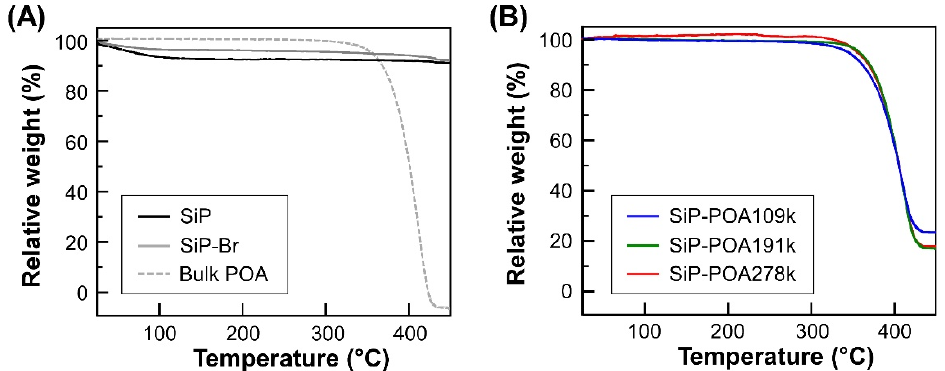
Figure 2. TGA curves for SiP, SiP-Br, bulk POA ( A ) and three kinds of SiP-POAs with different molecular weights of POA chains ( B ). molecular weights of POA chains ( B